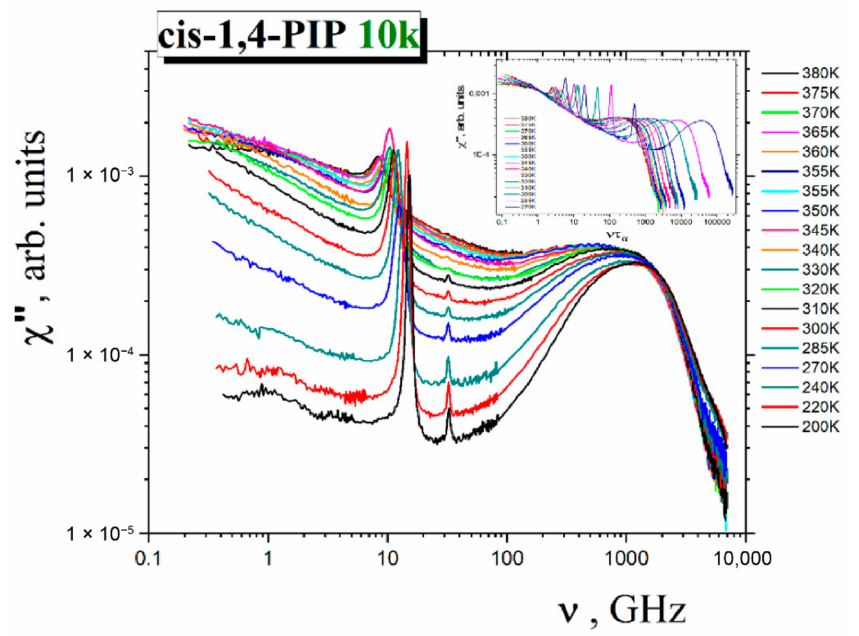
Figure 6. Light scattering spectra of cis -1,4-PIP10k at a series of temperatures from a broad tempera- ture range: 200–380 K. The inset shows the master plot; for its construction see the